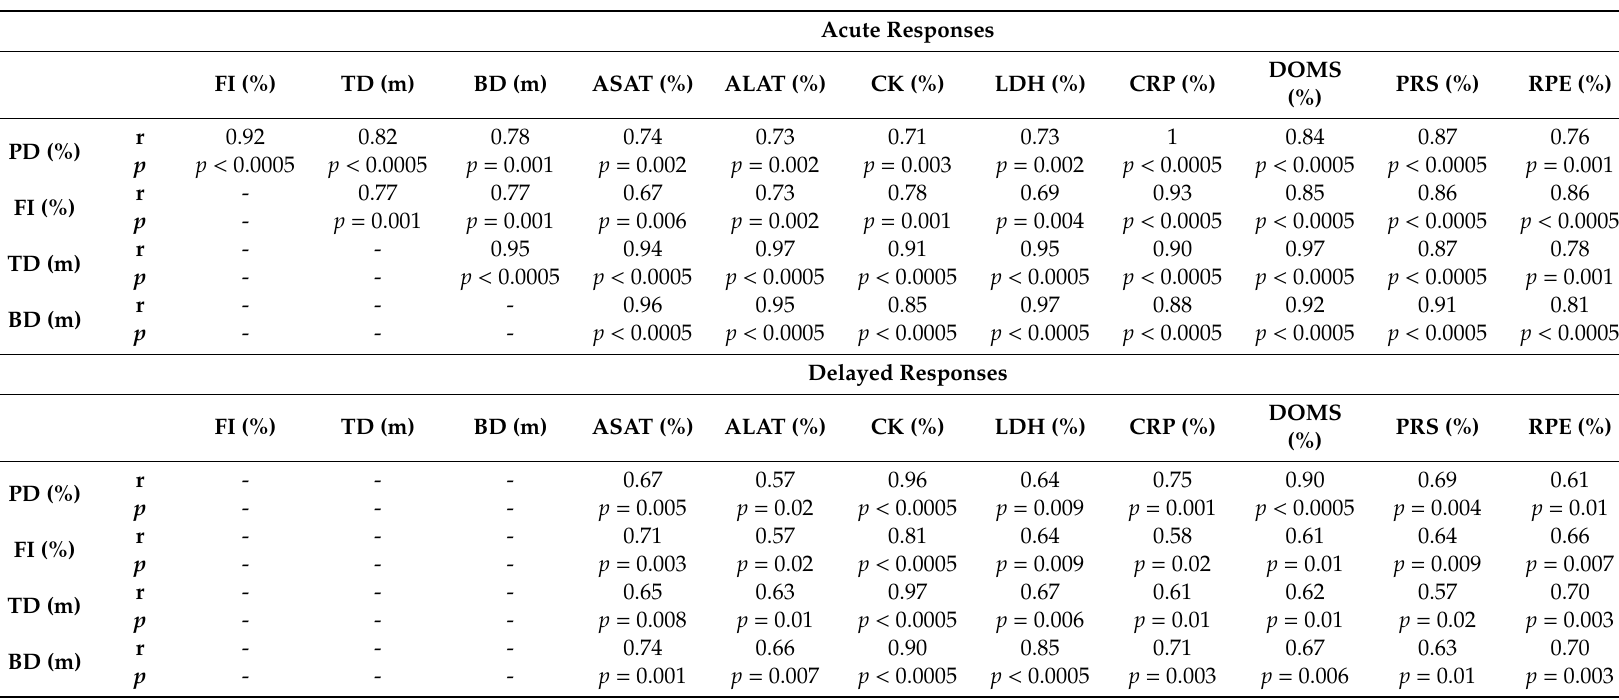
Table 3. Correlations between the physical performance and markers of muscle damage and inflammation as well as the perception of exertion (RPE), recovery (PRS), and muscle soreness